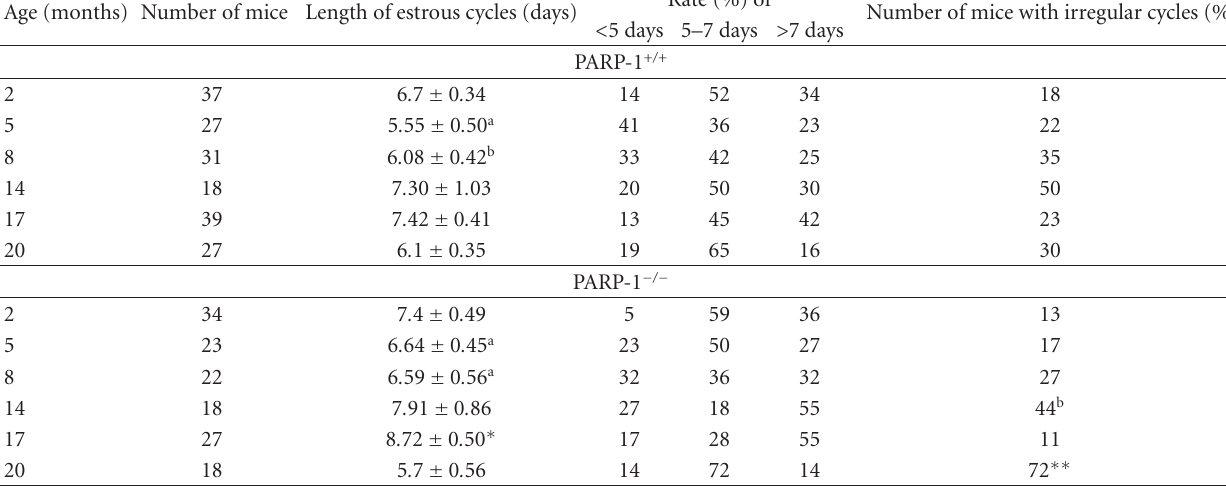
Table 1: Age-related dynamics of estrous functional parameters in PARP-1 − / − and PARP-1 + / + mice. Age (months) Number of mice Length of estrous cycles (days)